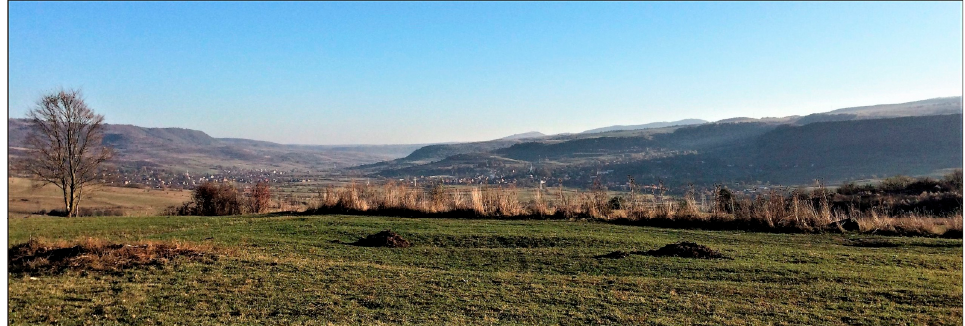
Figure 12. Topographic expression of the volcano spreading process and of relief inversion by ero- sion at the western periphery of the Gurghiu Mountains, as seen from the top of the Praid ”salt hill” looking North. The skyline flat topography represents the original surface of the western peripheral ring-plain of the Seaca-T ă tarca volcano, later modified by the volcano spreading process. Note the normal, gently outward-dipping slopes of the volcano in the left third of the picture (the central volcanic edifice is farther left, not seen in the picture), and the anomalous inward-dipping slopes in the right half of the picture, and the junction of them in between. The lowest topography corre- sponds to the level of valley incision through the volcanic formations down to the sedimentary basement so that now the peripheral volcaniclastic formations form a morphological plateau rising above the current valley levels (relief inversion). (Photo: Alexandru Szakács).